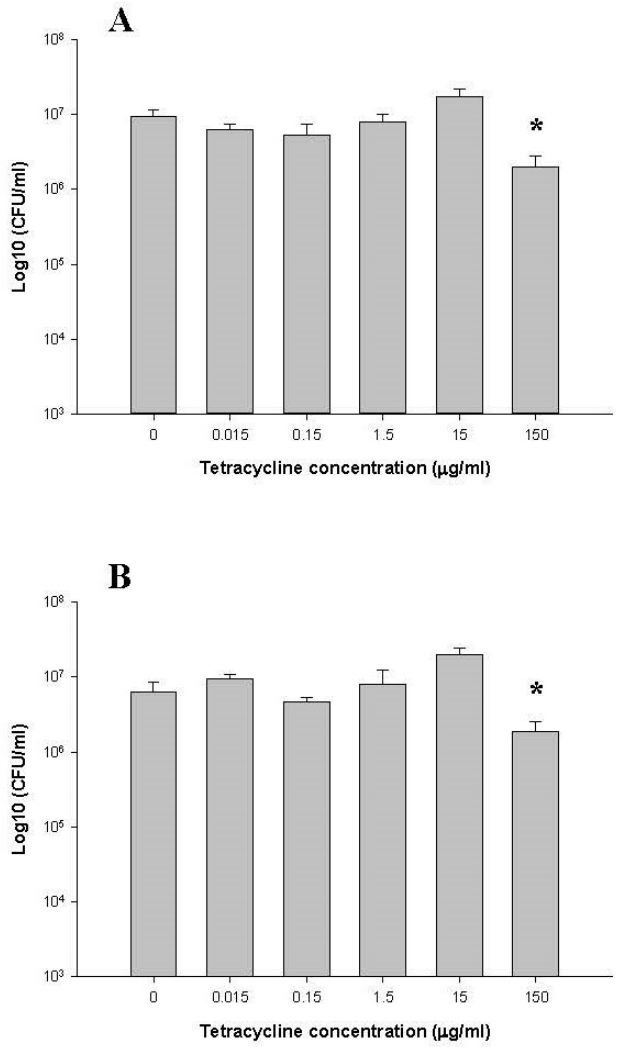
Figure 2. Comparison of total viable counts on BHI ( A ) and CDC ( B ) in controls (no treatment) and tetracycline-treated samples after 7 days. * indicates statistically significant differences from control ( p < 0.05).